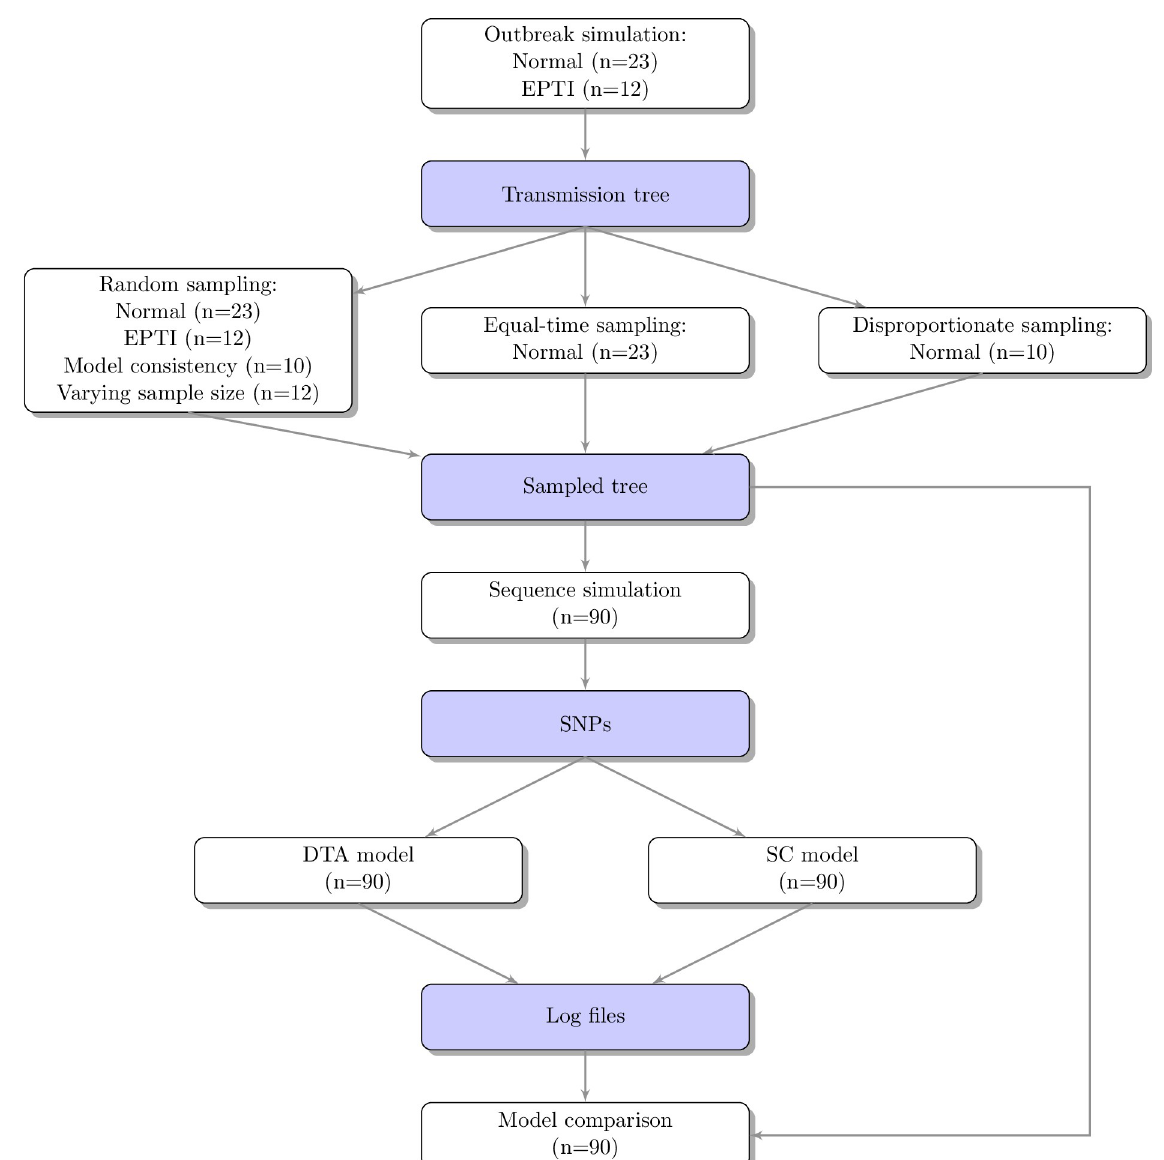
Fig 1. Flow diagram of the methods used to compare the SC and DTA models using various sampling methods. White rectangles represent the methods used and blue rectangles represent the data produced.